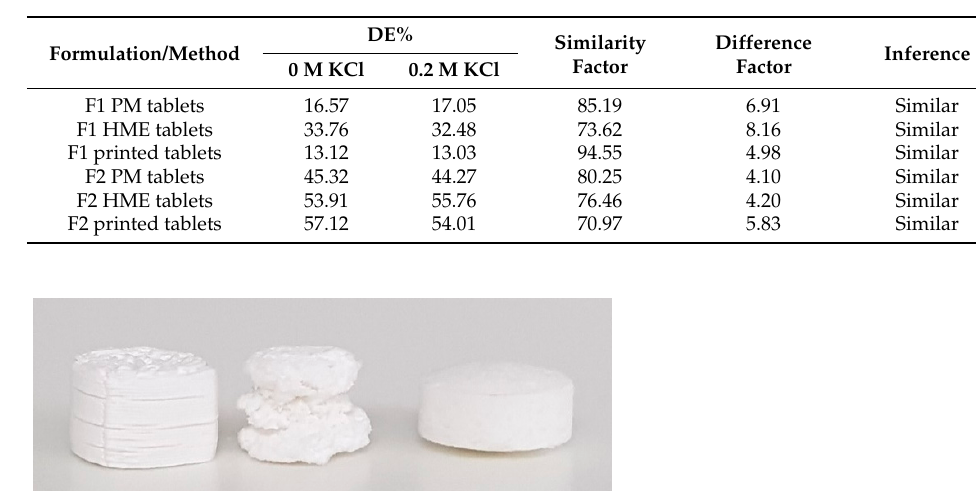
Table 4. DE% values obtained from dissolution testing performed with a dipping rate of 10 dpm at two different ionic strengths, the baseline ionic strength (0 M KCl added) and 0.2 M added KCl, along with similarity ( f 2 ) and difference ( f 1 ) factors for these two profiles.